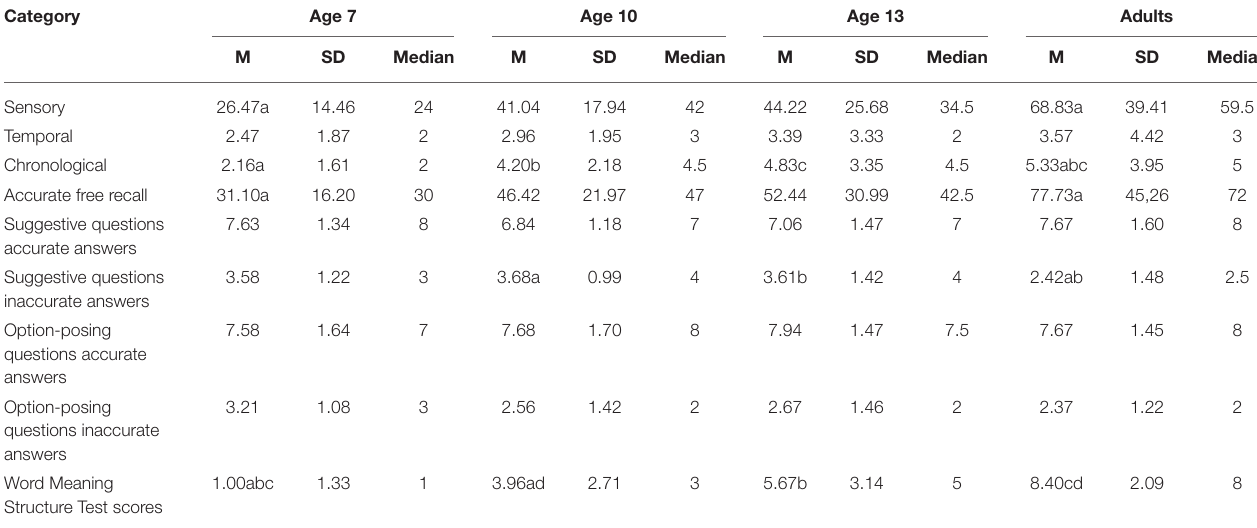
TABLE 1 | Children’s and adults’ responses to different question